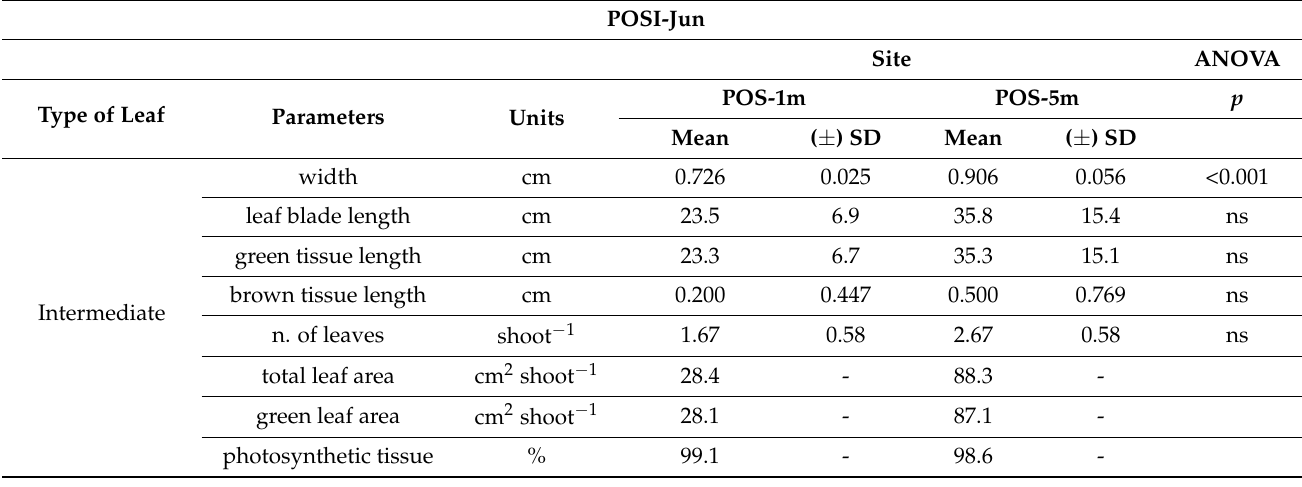
Table 1. Morphometric parameters of P. oceanica sampled during POSI-Jun at two sites, POS-1m and POS-5m, respectively. Parameters are classified as [77] and shown as representative for each